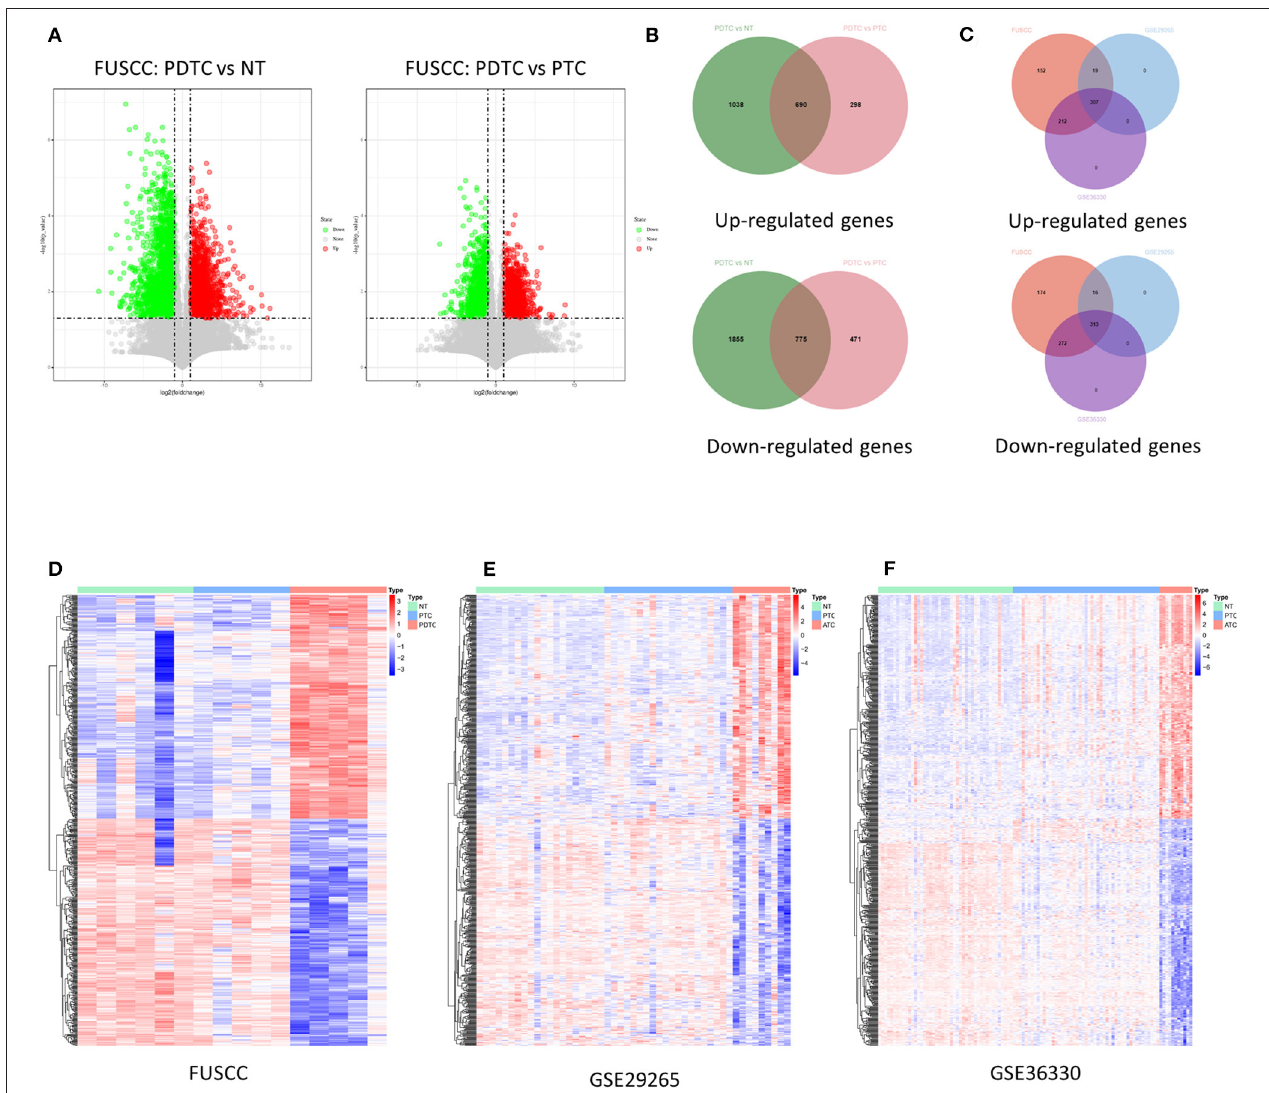
FIGURE 1 | Identification of deregulation of genes in DDTC. (A) Volcano maps: left map, 1,728 downregulated genes (green dots) and 988 upregulated genes (red dots) in PDTCs compared with NT tissues; right map, 2,630 downregulated genes (green dots) and 1,246 upregulated genes (red dots) in PDTCs compared with PTCs; fold change (FC) ≥ 2, p < 0.05. (B) Compared with PTC and NTs, overlap of abnormal expressed genes in PDTC. (C) The Venn diagram showed that 1,465 genes abnormally expressed in the FUSCC cohort were validated into GSE29265 and GSE33630, and 313 downregulated genes and 307 upregulated genes were screened out. (D–F) The heat map shows the expression data of 620 dysregulated genes in the FUSCC cohort, GSE29265 cohort, and GSE33630 cohort. DDTC, dedifferentiated thyroid cancer; PDTC, poorly differentiated thyroid cancer; NT, normal thyroid; PTC, papillary thyroid cancer; FUSCC, Fudan University Shanghai Cancer